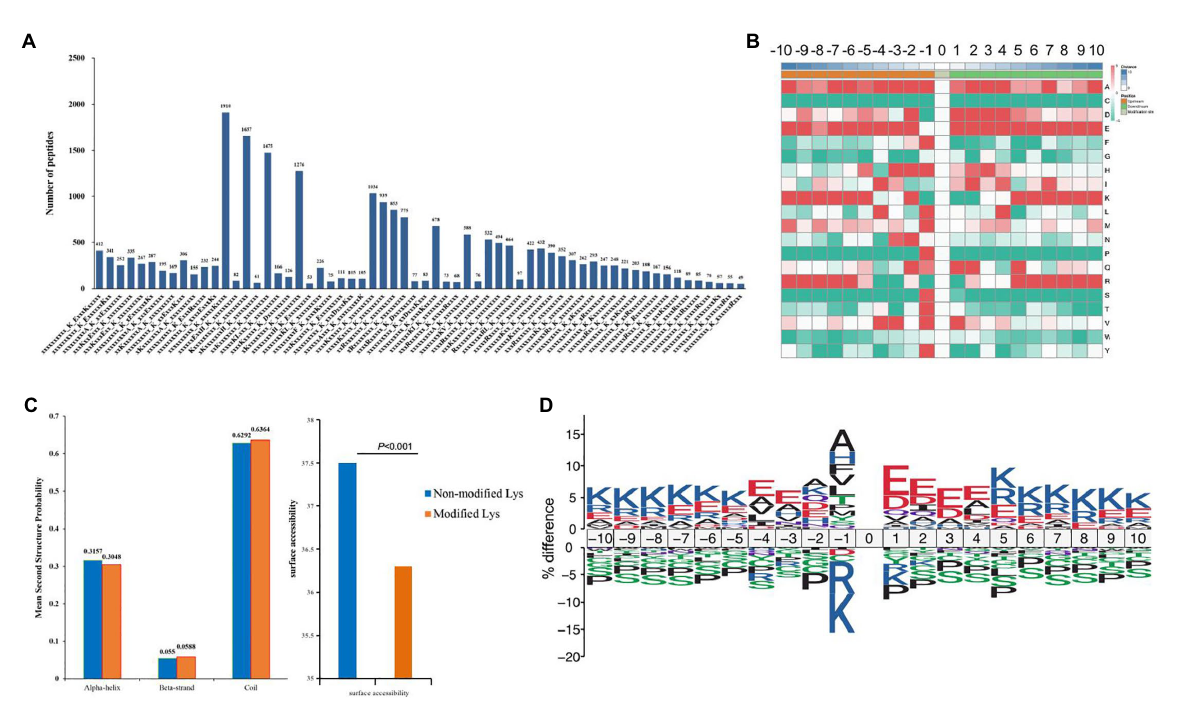
FIGURE 5 Motif analysis of all identified crotonylated sites in folate-free mESCs. (A) Motif statistics of recognized peptides involving crotonylation sites. (B) Heatmap showing the different types of amino acids near crotonylated lysines. (C) Secondary structure statistics involving identified lysine crotonylation sites. Comparison of various secondary structures ( α -helix, β -strand, coil and surface accessibility) involving identified crotonyllysine and all lysine secondary structures. (D) IceLogo representation showed sequence preferences for all lysine crotonylation